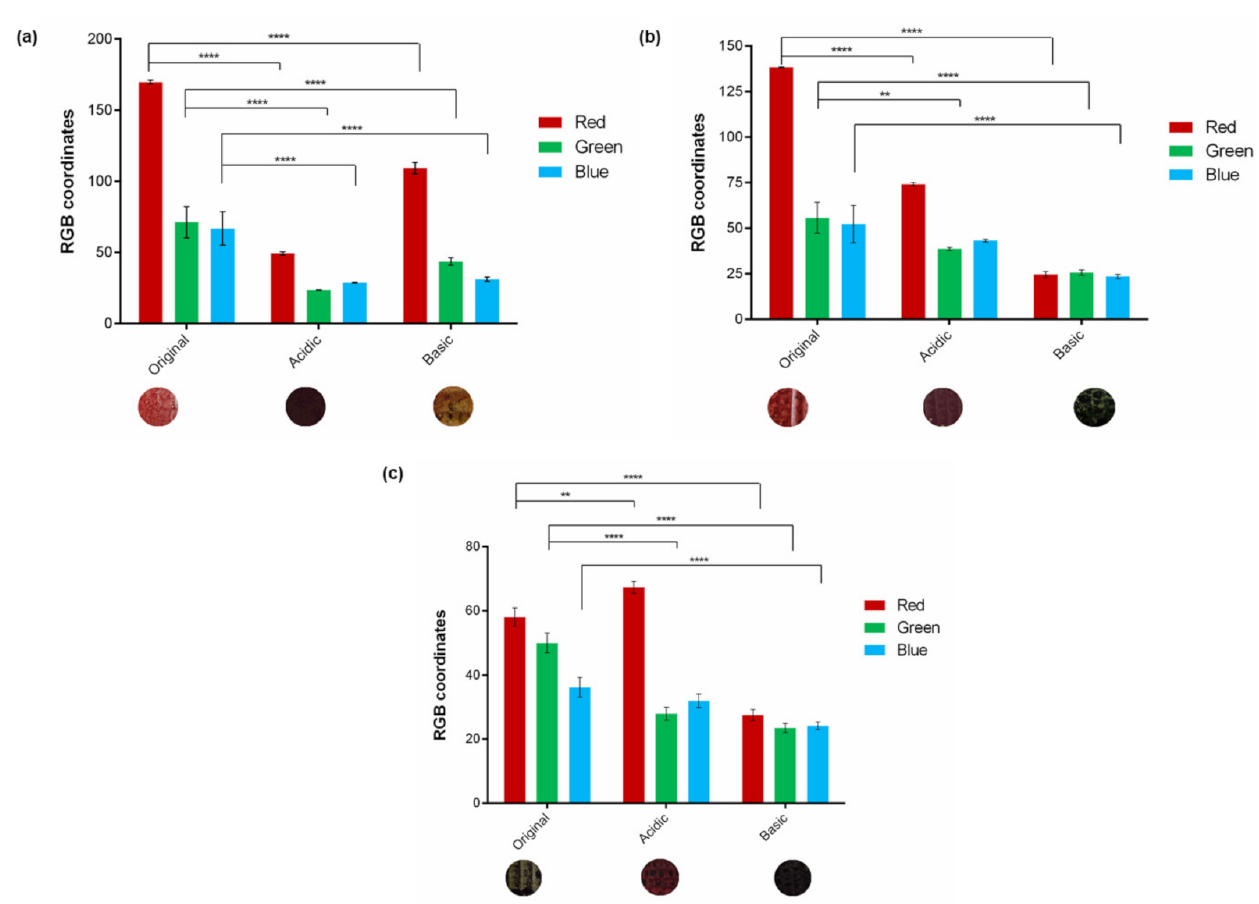
Figure 8. RGB coordinates and color palette presented by the samples ( a ) MR:MRs 1% ( w / v ), ( b ) MR:BB 1% ( w / v ), and ( c ) MO:BP 1% ( w / v ) before (original) and after exposure to acidic and basic environment ( n = 3, ± SD), ** p < 0.01, **** p < 0.0001 (one-way ANOVA, Š í d á k’s